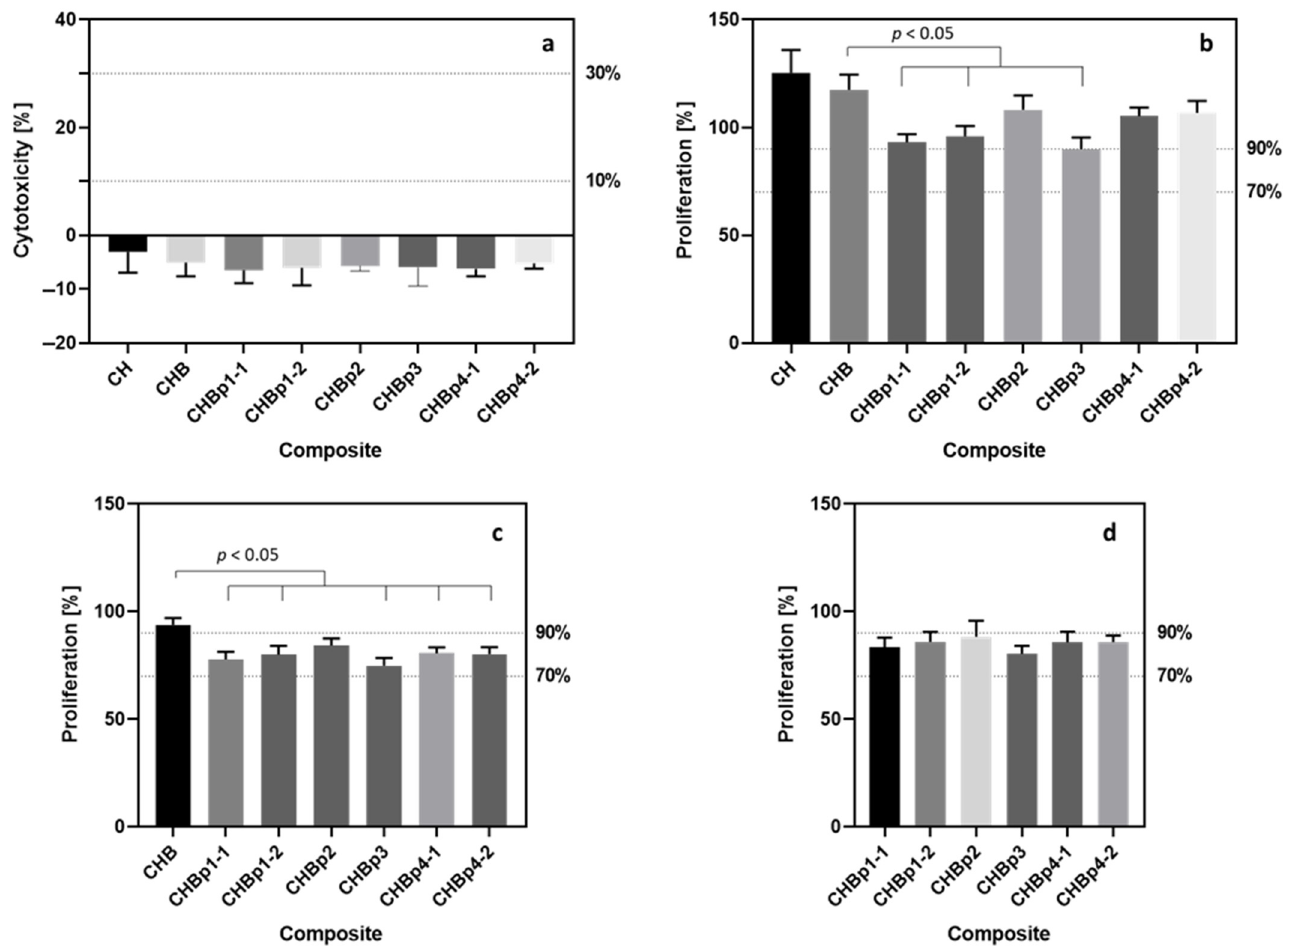
Figure 1. Cytotoxicity ( a ) and proliferation of hFOB 1.19 cells calculated with the use of different controls’ absorbance: ( b ) nontreated control cells, ( c ) cells growing in CH extract, ( d ) cells growing in CHB extract. Data shown include results from two technical repeats of the experiment. Each repeat contained triplicates of untreated cells and cells treated with CH, CHB, CHBp extracts. CHBp extracts were numbered due to the presence of different peptides and their variable concentrations in the composites: p1-1—2.1765%, p1-2—0.0560%, p-2—0.1750%, p-3—0.0077%, p4-1—0.1594%, p4-2—0.2906%. The most important statistically significant differences are marked as p < 0.05. Full results of statistical analysis can be found in Supplementary Material (Tables